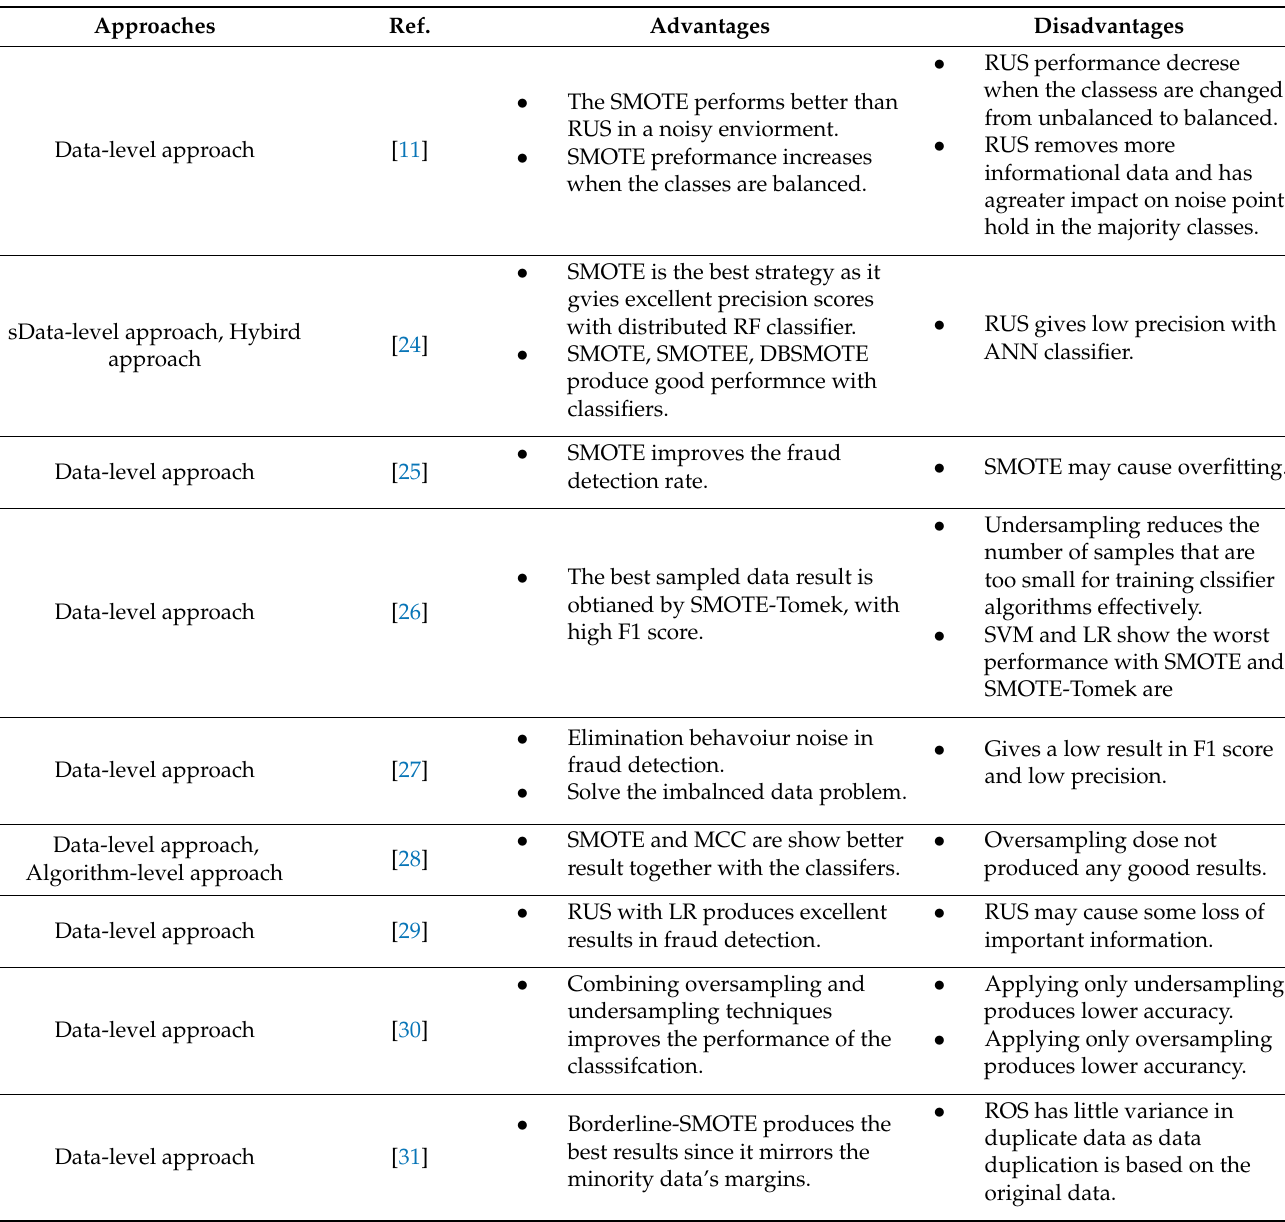
Table 2. Taxonomy of advantages and disadvantages of sampling approaches among the re- viewed